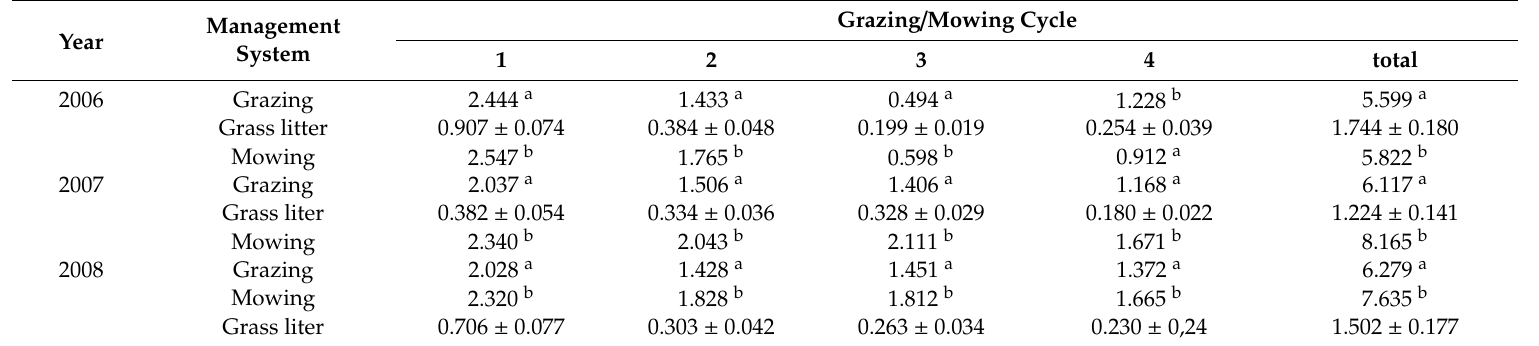
Table A2. Yields of grass sward in the consecutive grazing / mowing cycles, t ha − 1 DM.